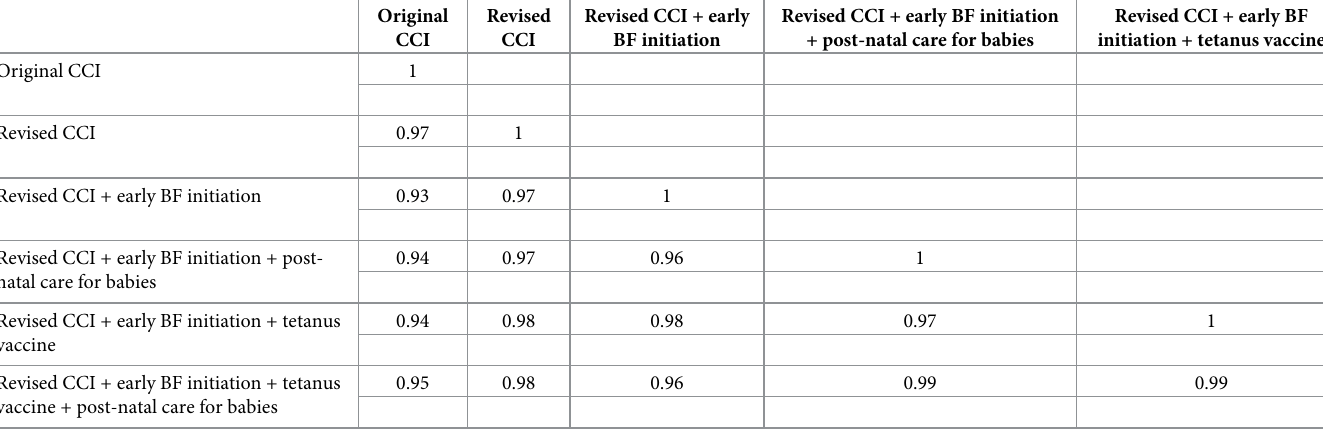
Table 3. Correlation matrix for the different formulations of the CCI in 47 countries.